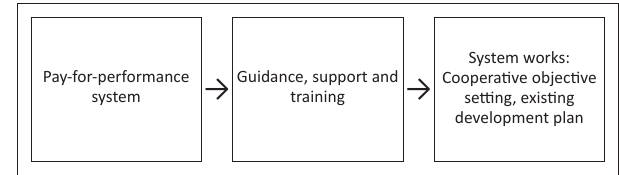
Pay-for-performance FIGURE 2: Programme theory for an effective pay-for-performance system for administrative employees.